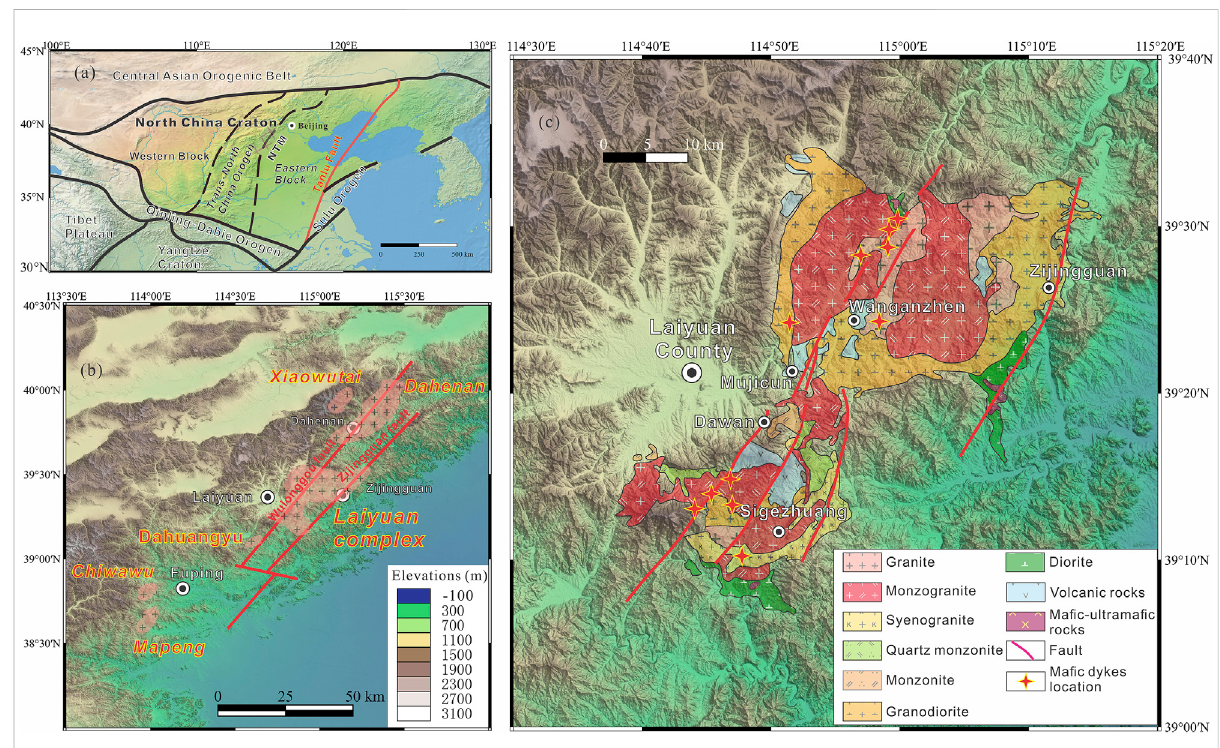
FIGURE 1 (A) Tectonic subdivision of the North China Craton (modi fi ed after Zhao et al., 2005). (B) Simpli fi ed geological map showing thedistributions of Mesozoic intrusions in the NTM. (C) Geological map of the Laiyuan magmatic complex after the mineral and geological map in Laishui-Yixian areas (1979) and the locations of dyke